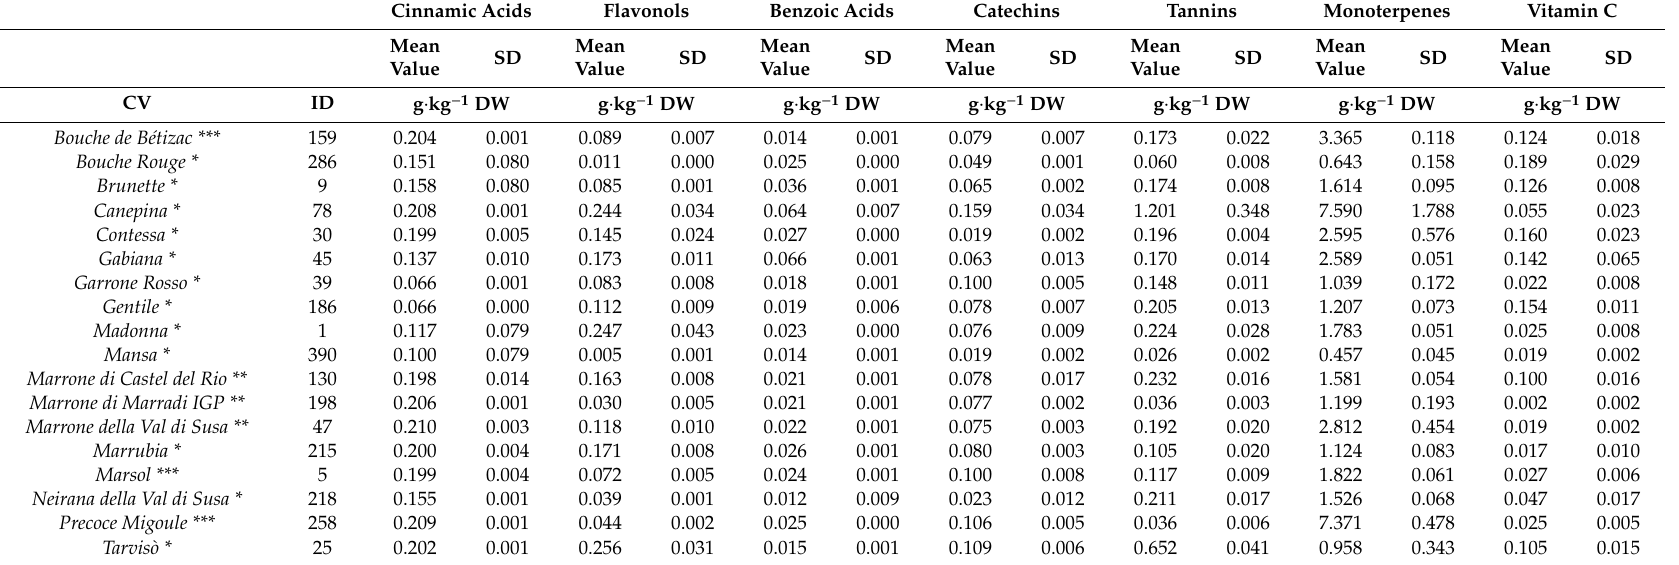
Table 4. Chestnut phytochemical class